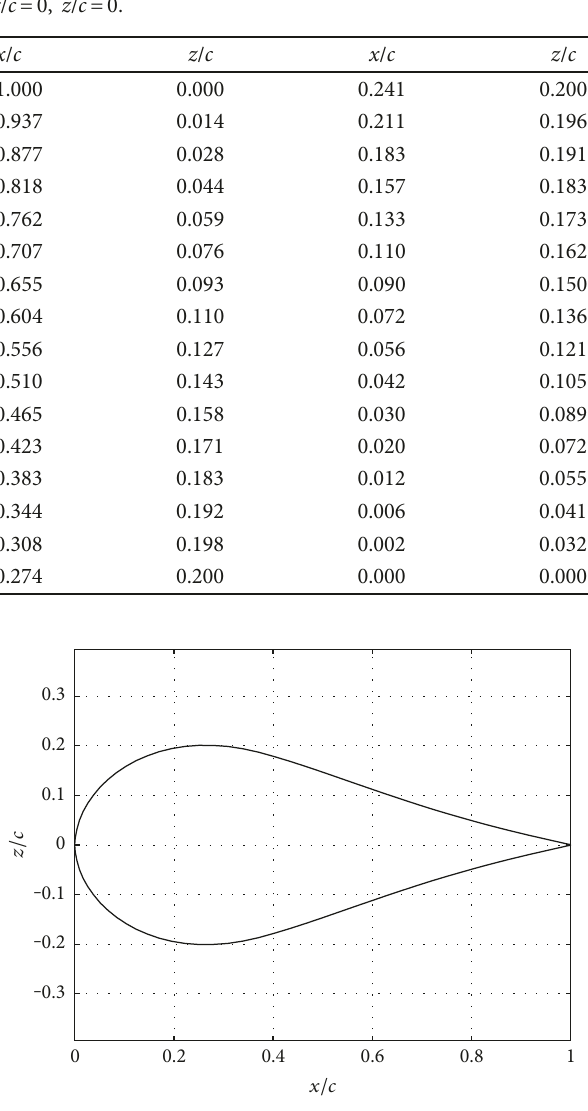
Figure 1: Airfoil pro fi le shape.